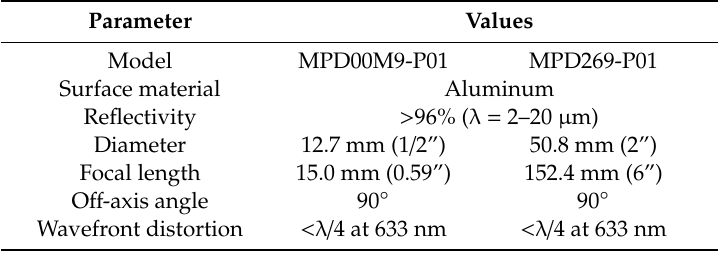
Table 2. Parameters of collimator mirrors.